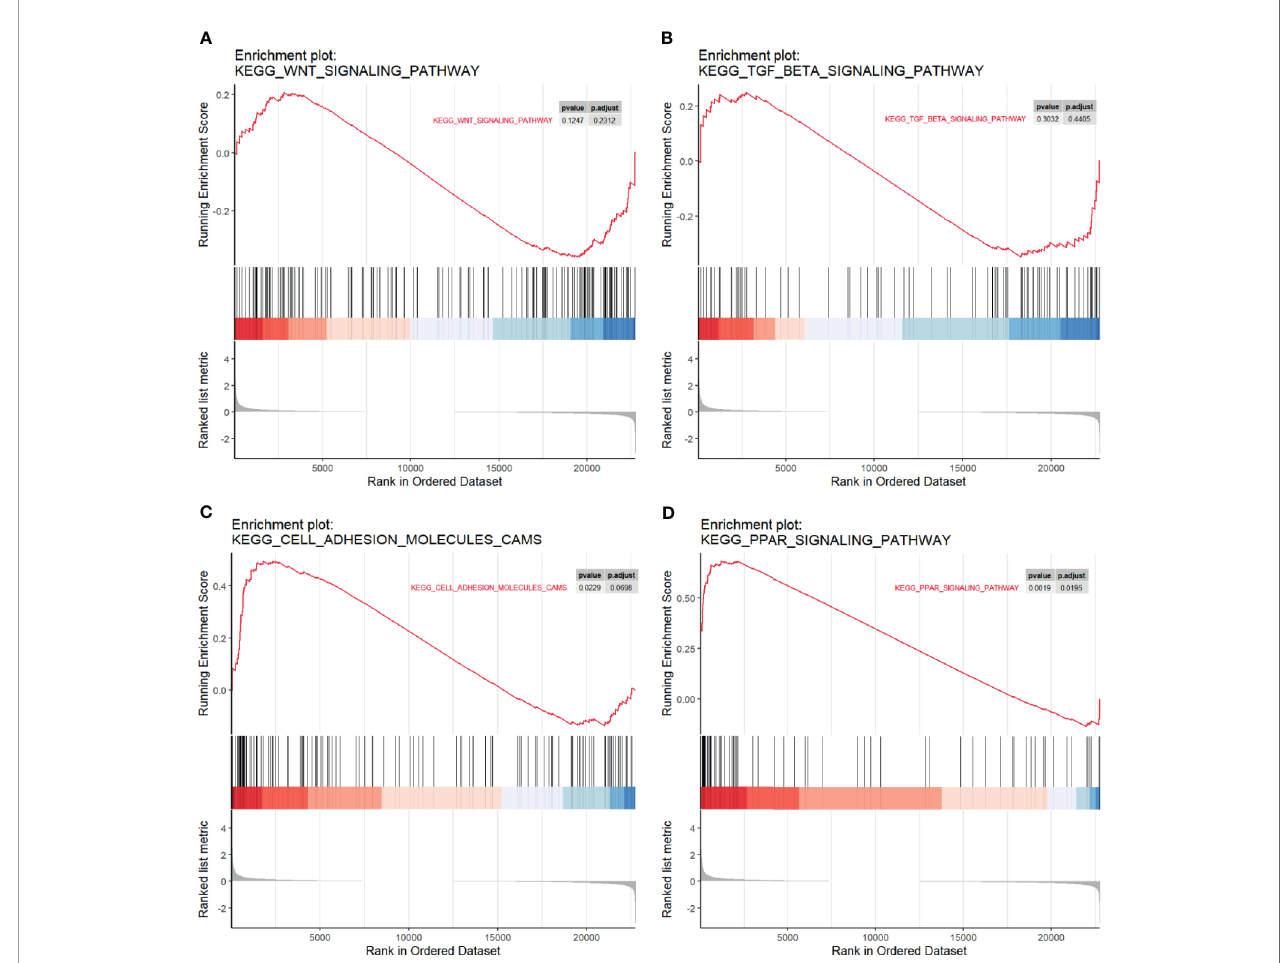
FIGURE 3 | Gene set enrichment analysis (GSEA) plots. The enrichment of the (A) Wnt pathway, (B) TGF-beta pathway, (C) cell adhesion molecules, and (D) PPAR pathway in different genes among four GSE series. Ranked list metrics were determined by log2(fold